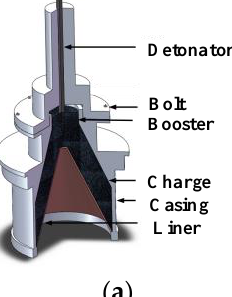
Figure 1. Shaped-charge structure and penetrating effect [25]: ( a ) Shaped charge; ( b ) Shaped charge penetrating concrete target.